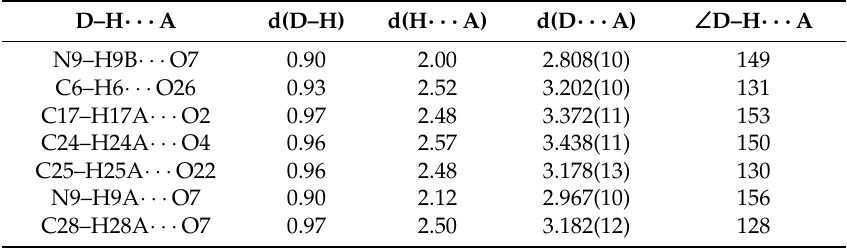
Table 4. Hydrogen bonding interactions (Å, ◦ ) of the Ni(II)